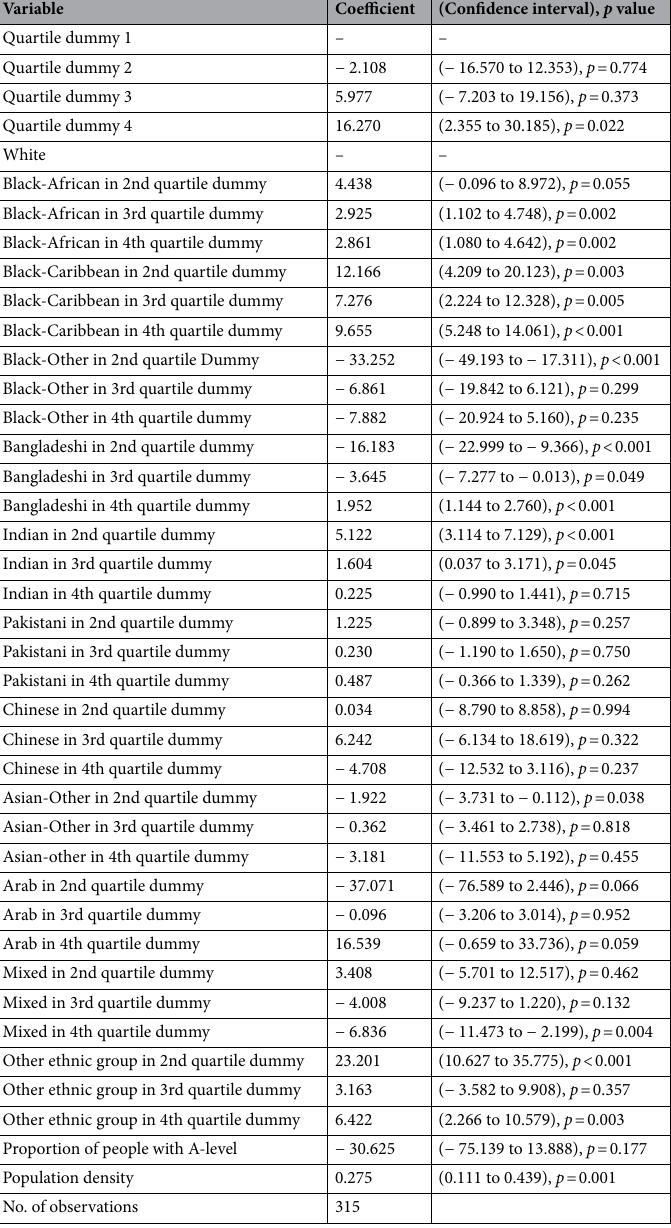
Table 2. Age adjusted mortality rates and association between ethnicity and index of multiple deprivation, linear regression model: coefficients (95% confidence interval, P value). White ethnicity is being used as the base